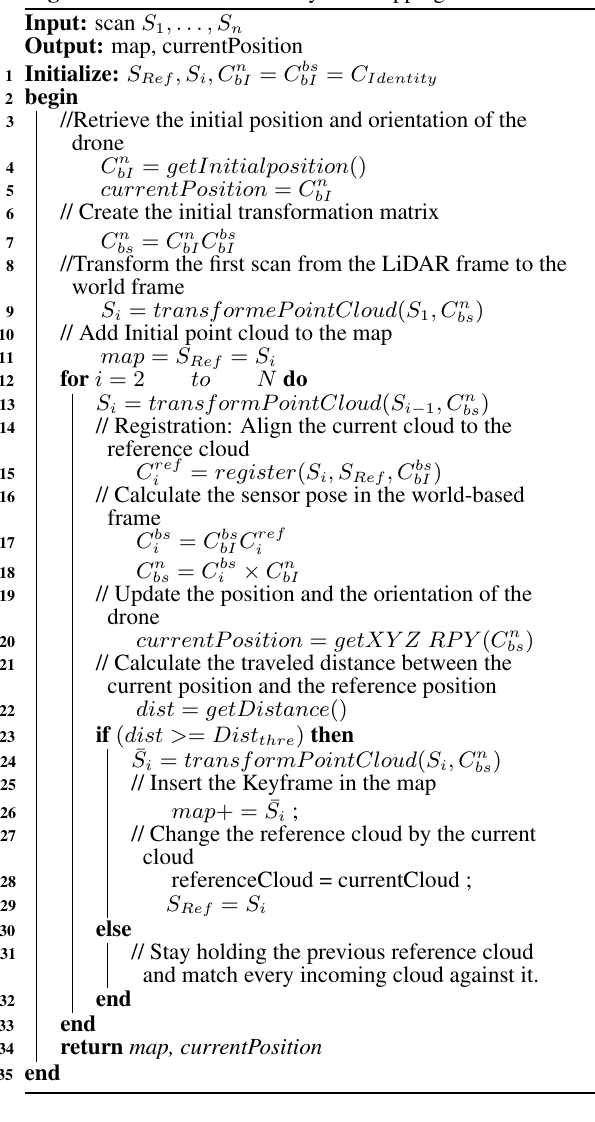
Algorithm 1: LiDAR odometry and mapping